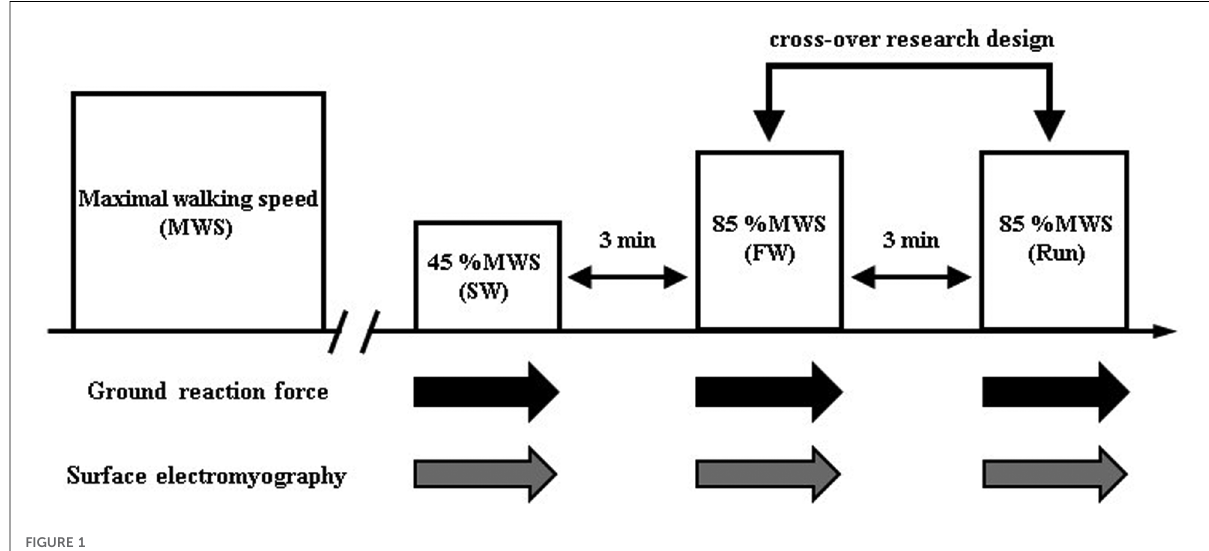
FIGURE 1 Protocol overview.